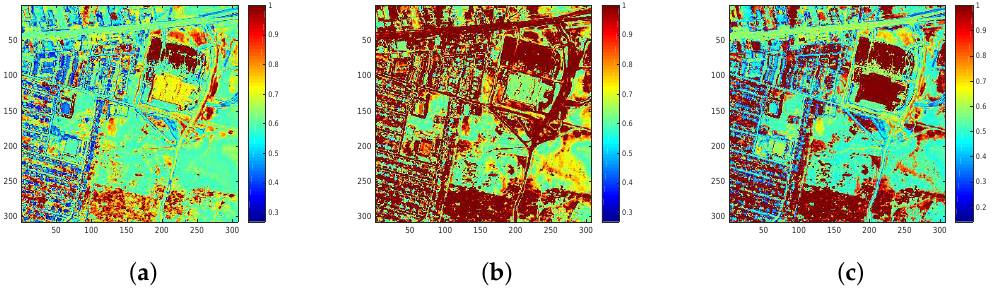
Figure 13. The sparseness maps of abundance results obtained by different algorithms. ( a ) L 2 -NMF; ( b ) L 1/2 -NMF; ( c )